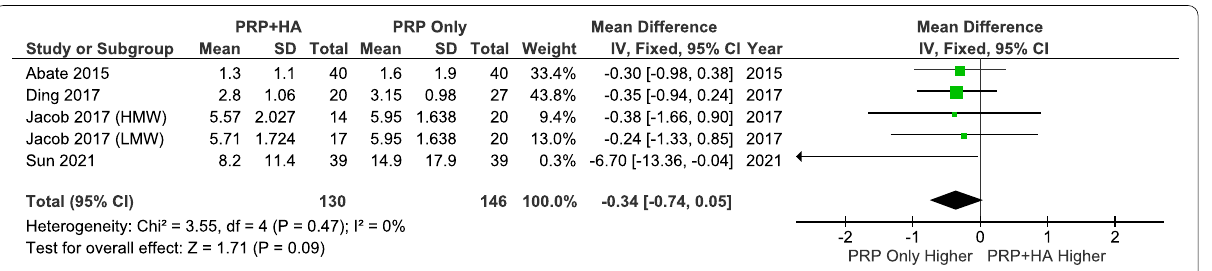
Fig. 7 Showing the Forest plot comparing the VAS scores between PRP